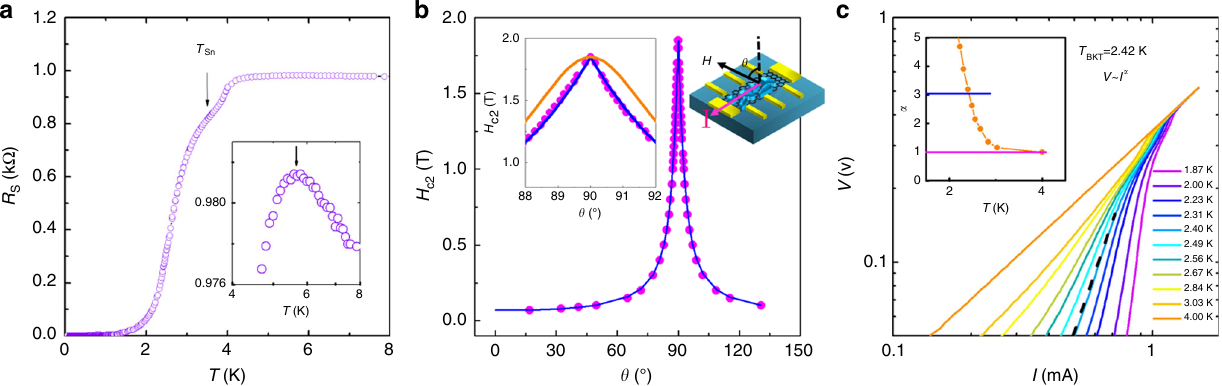
Fig. 2 Two dimensional superconductivity of graphene – tin nanoislands array. a The four-terminal sheet resistance ( R s ) versus temperature ( T ). The black arrow indicates the critical temperature of bulk tin T Sn = 3.7 K. Inset: R s - T curve on the semi-logarithmic scale from 4 K to 8 K. The R s peak hints the superconducting fl uctuation. b The upper critical fi elds H c2 as a function of the angle θ . θ is the angle between the magnetic fi eld and the surface normal direction of the device with current fl owing always in plane, as sketched in the right inset. The blue solid line and the orange solid line correspond to the ð θ Þ sin θ = H k Þ 2 þ j H ð θ Þ cos θ = H ? j ¼ 1 and the 3D anisotropic mass model theoretical fi tting of the H c2 ( θ ) using the 2D Tinkham formula ð H c 2 c 2 c 2 c 2 ð θ Þ ¼ H k = ð sin 2 ð θ Þ þ γ 2 cos 2 ð θ ÞÞ 1 = 2 with γ ¼ H k = H ? H , respectively. H k and H ? represent the upper critical fi eld parallel and perpendicular to the surface c 2 c 2 c 2 c 2 c 2 c 2 of the device, respectively. c Voltage – current ( V – I ) curves on logarithmic scale at various temperatures. The black dashed line represents V = I 3 . Inset shows the extracted power-law fi tting exponent α as a function of the temperature. The Berezinskii-Kosterlitz-Thouless (BKT) temperature T BKT = 2.42 K